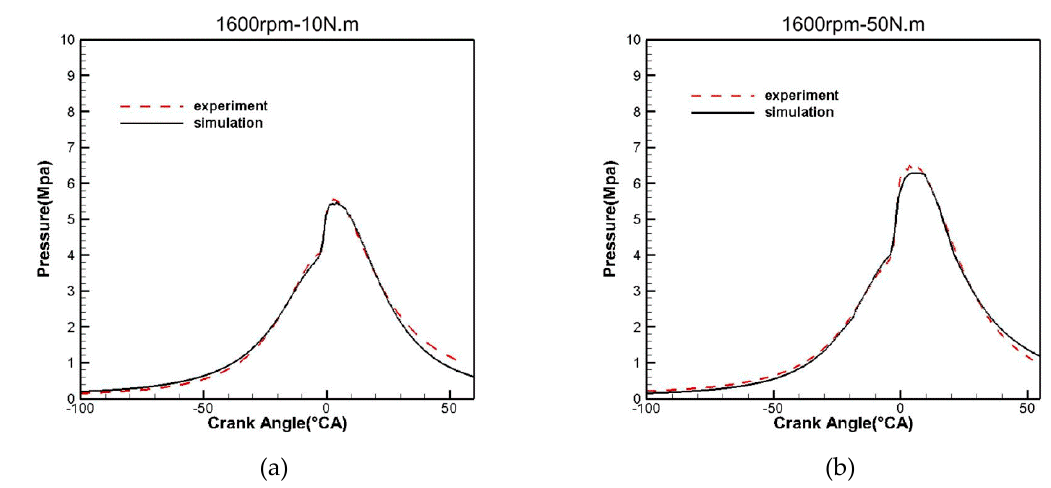
Figure 14. Comparison of simulation and experimental combustion pressure with a load of (a)1600rpm-10N.m and (b)1600rpm-50N.m